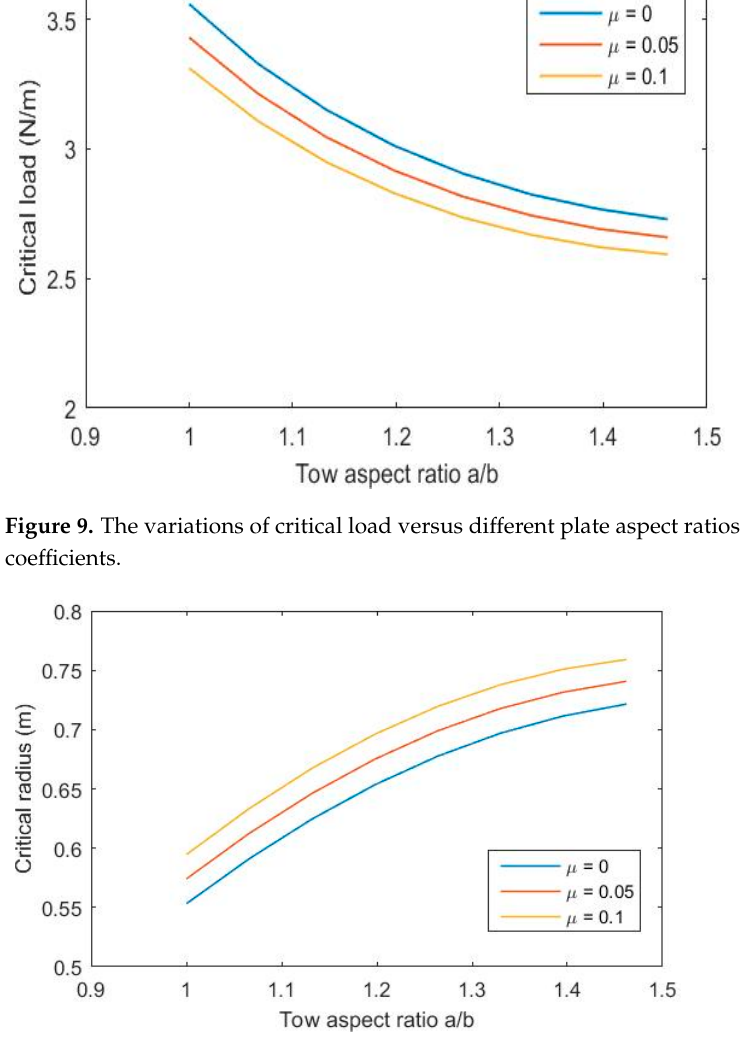
Figure 10. The variations of critical radius versus different plate aspect ratios and initial defect coefficients.